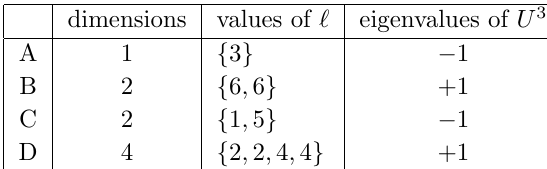
Table 1 . Primary decomposition of solution space of BAE with M = 6. The numbers on the right-hand sides of each line represent the dimension of each subspace.